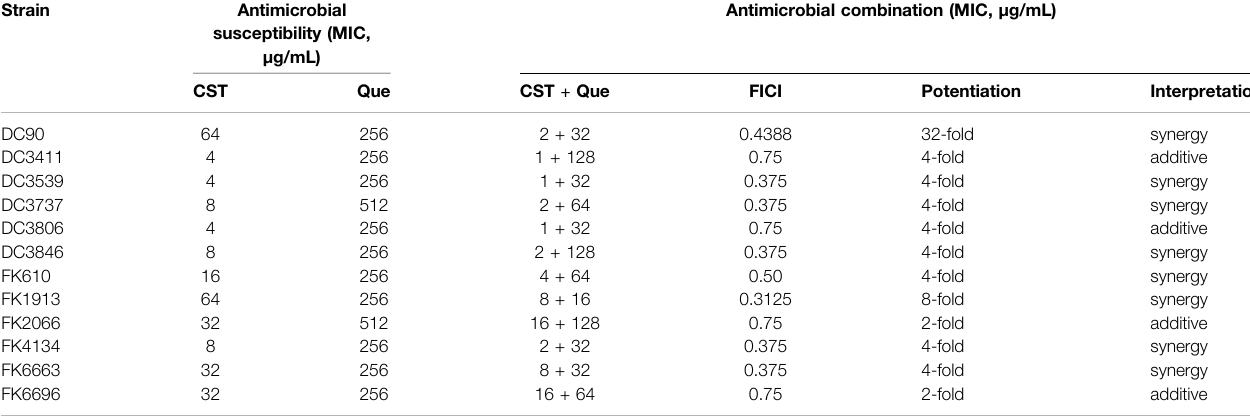
Antimicrobial combination (MIC, μ